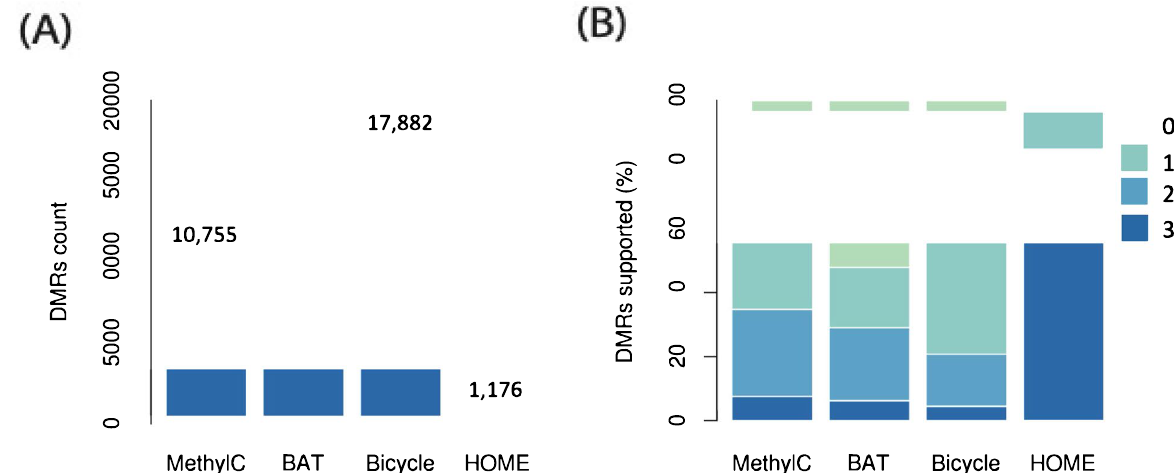
Fig. 3 DMR calling comparison. A Number of CG DMRs called by MethylC‑analyzer, BAT, Bicycle, and HOME using the Arabidopsis WGBS data. B The percentage of DMRs confirmed by the DMRs calling tools. The color key indicated the number of other DMR tools detected the same DMR. For example, "0" is the set of DMRs predicted by only one caller, and "3" is the set of DMRs predicted by all